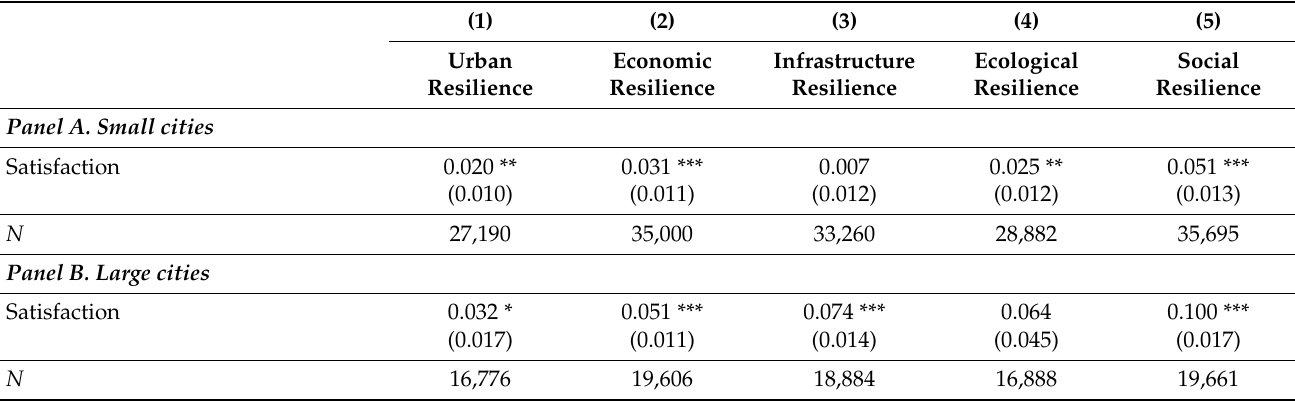
Table 5. Effect of urban resilience on residents’ subjective happiness by city